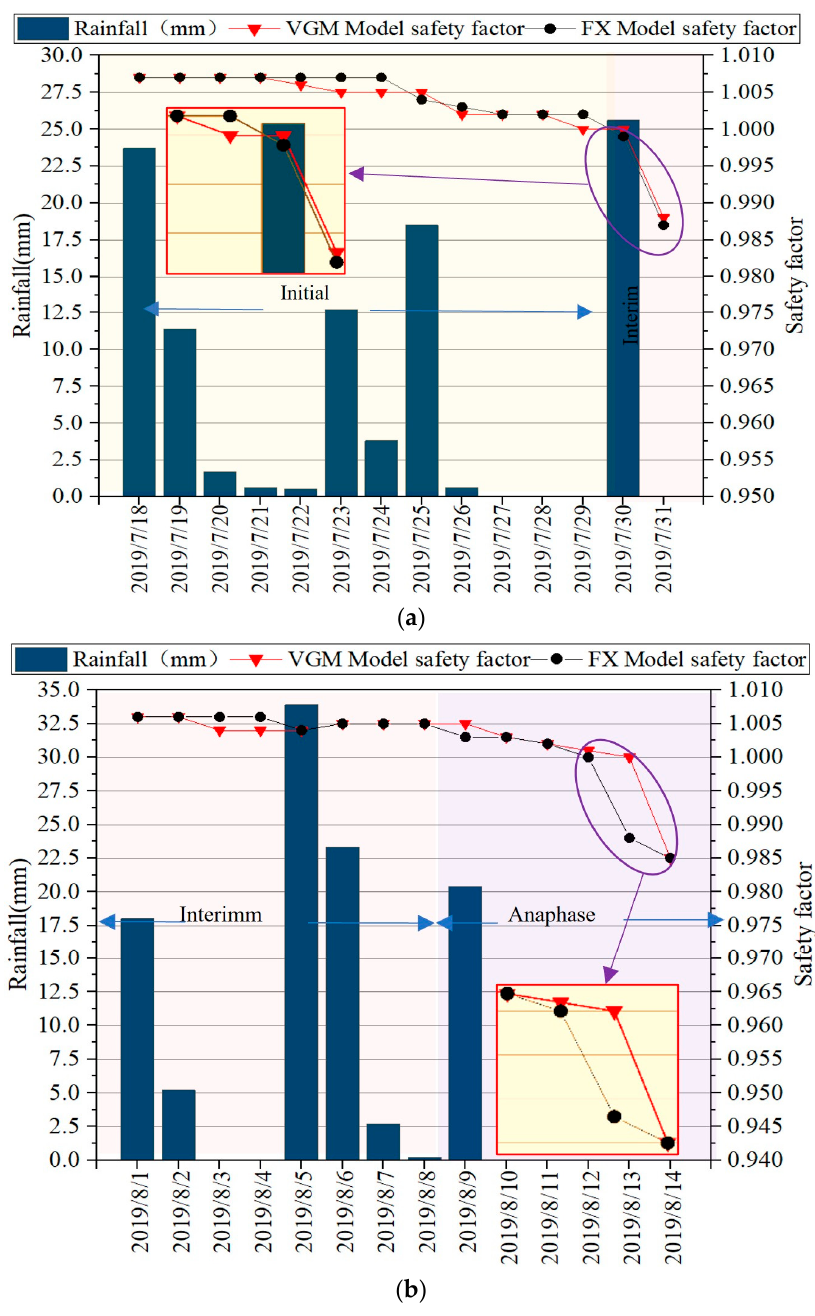
Figure 12. Landslide stability evolution curve of the 2-2 profile under rainfall conditions: ( a ) the first slide, ( b ) the second slide.